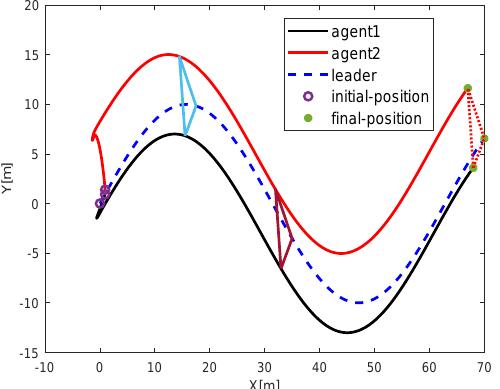
Figure 7. Formation control without considering obstacles.